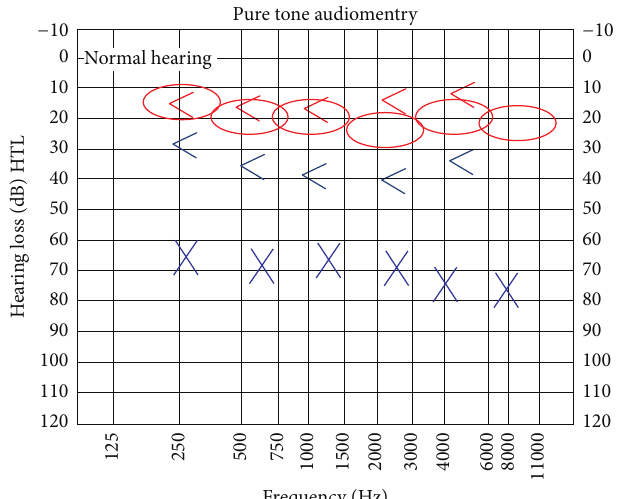
Figure 1: Left conductive hearing loss.